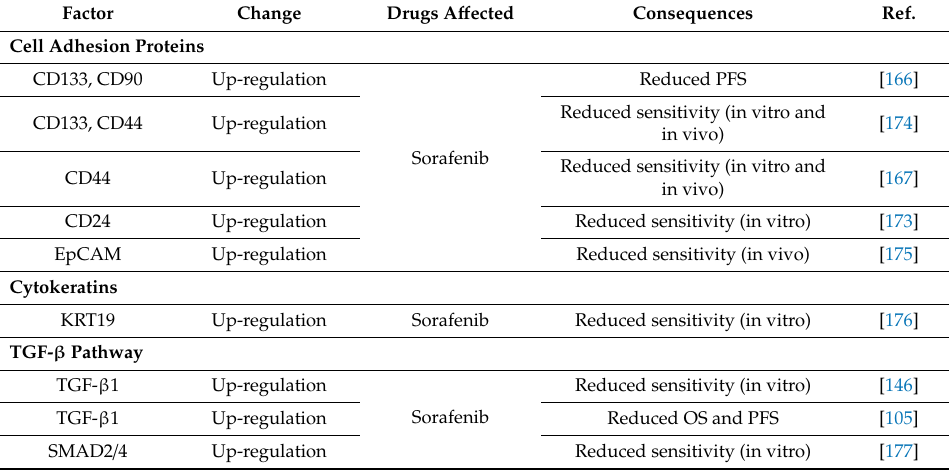
Table 5. Mechanisms of chemoresistance type 7 (MOC-7) to drugs clinically used in HCC. Factor Change Drugs A ff ected